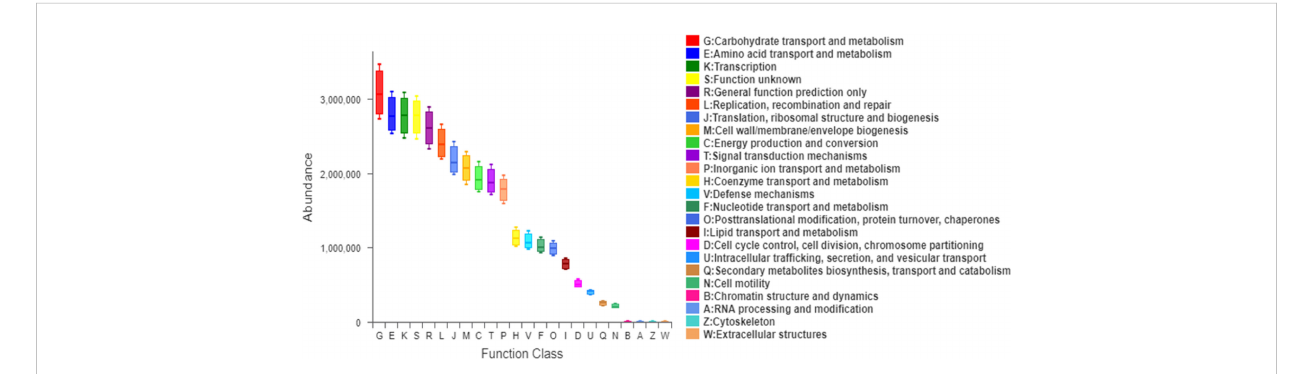
FIGURE 7 Functional prediction and comparison of gut microbiota between T2DM and non-T2DM